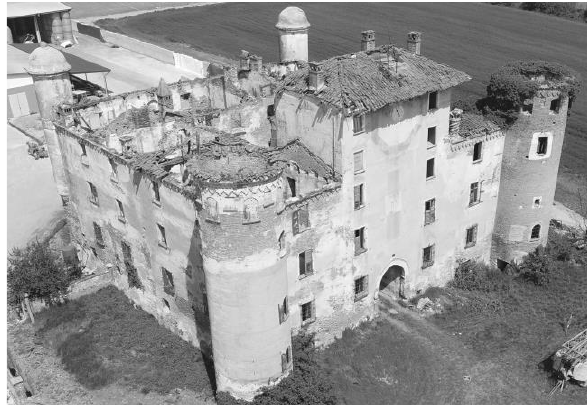
Figure 1 . Drone Phantom 4 Pro picture of the ruins of Castle.